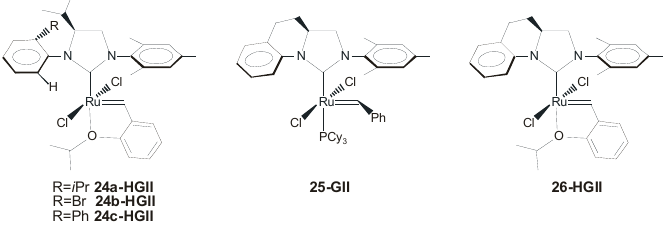
Figure 17. Catalysts with backbone-monosubstituted NHCs.